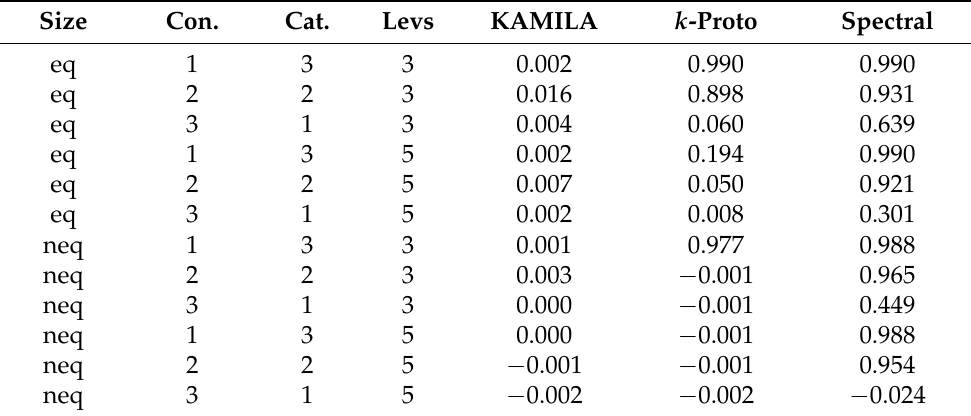
Table 3. Median ARI for high overlap in continuous variables and low overlap in categorical variables, n = 100 two-cluster data sets.